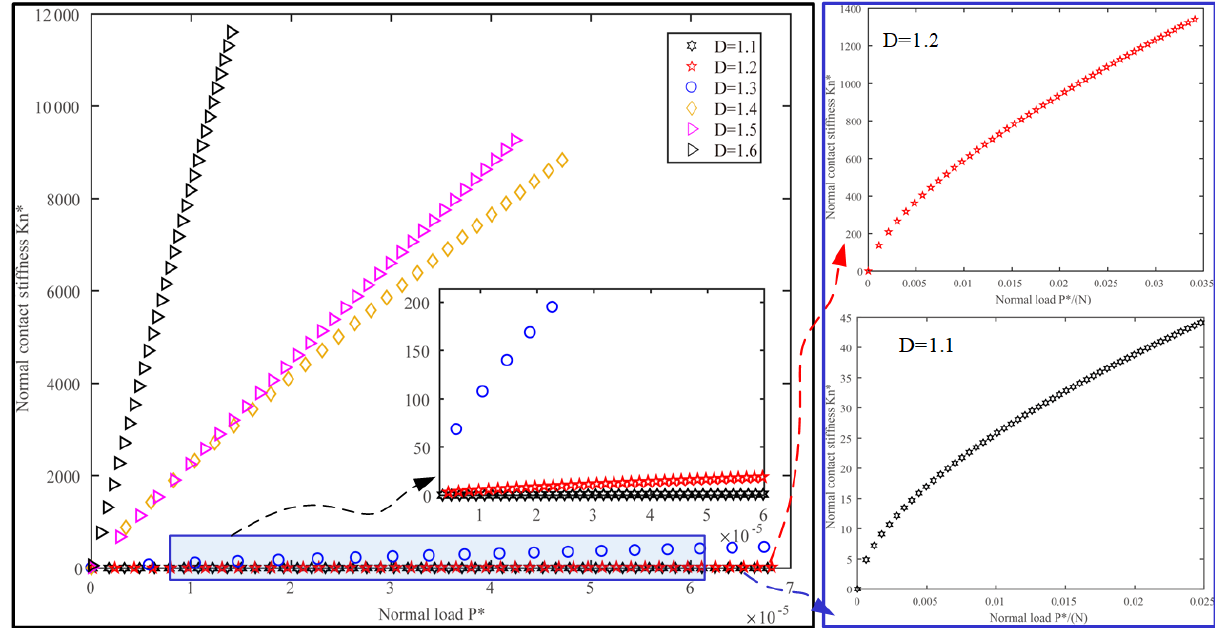
Figure 4. Effects of normal load P ∗ on normal contact stiffness K ∗ n ( k = 1 . 0, φ = 1 . 0, G ∗ = 1 . 0 × 10 − 10